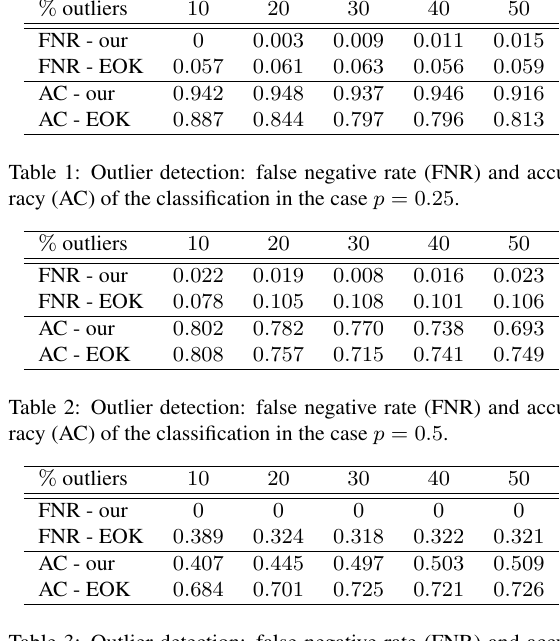
Table 3: Outlier detection: false negative rate (FNR) and accu- racy (AC) of the classification in the case p = 0 . 8 .